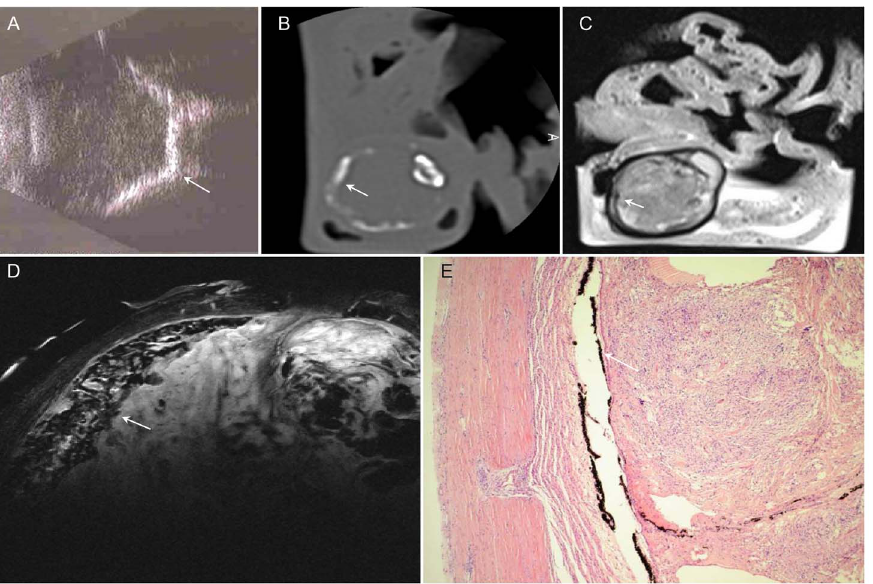
Figure 7. Premature retinopathy with phthisis and calcification of ocular wall (arrow). A – Sonography: Hyperreflective line corresponding to ossification process of bulbar wall. B – CT reconstructed in the bone window: corresponding plane to the MR image; the gross calcifications appear as linear hyperdensities. C – T2w image at 1.5 T: Bulbar wall with very low signal intensity; the vitreous body is of inhomogeneous low signal intensity, and ultrastructures cannot be identified with certainty. D – Sagittal T2w image: Thickened retina with very low signal intensity as a sign of calcification; intraocular scar tissue is characterized by inhomogeneous MR signal intensity. E – H&E stain, 4 6 magnification: Histologically, the intraocular space is filled with fibromatous scar tissue, and there is ossification of the bulbar wall originating in the pigment